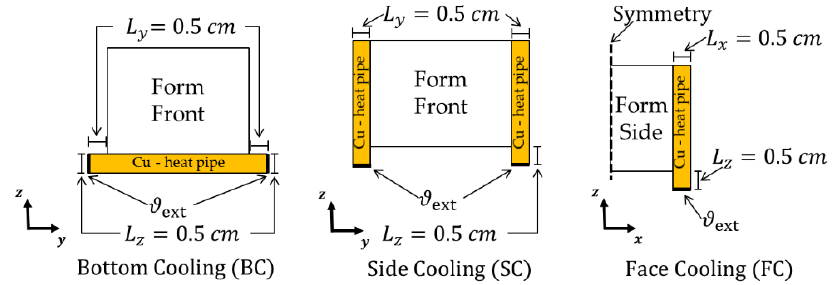
Figure 6. Layout of the conductive cooling concept variations bottom cooling (BC), small side cooling (SC) and large face cooling (FC).